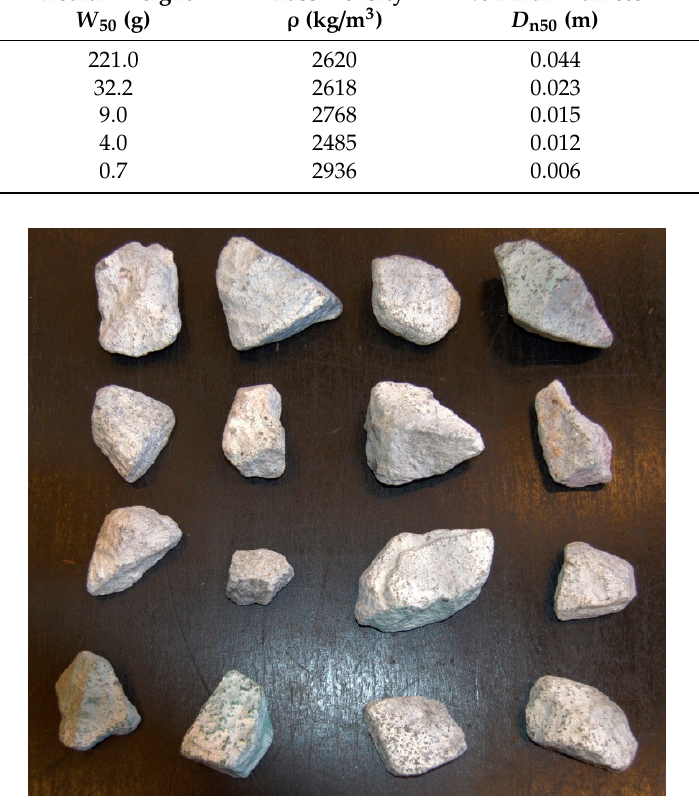
Figure 3. Class I rocks used in the armor layer for the present tests.